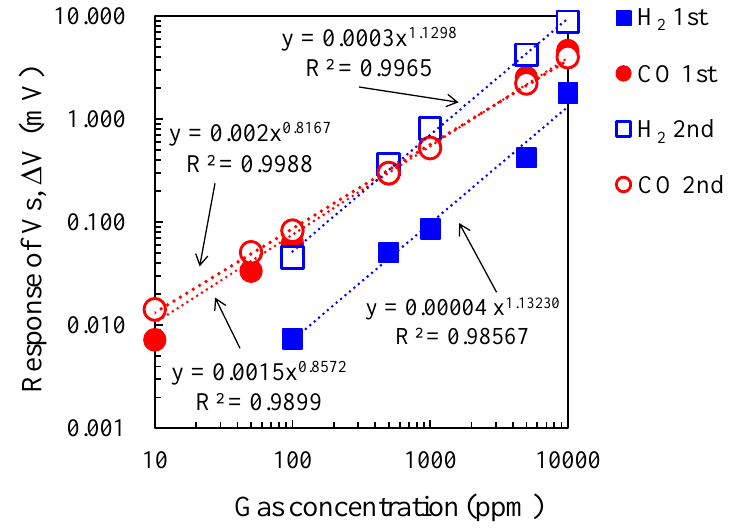
Figure 9. ΔV against CO and H 2 concentration for the micro-TGS, from 10–10,000 ppm in dry air.